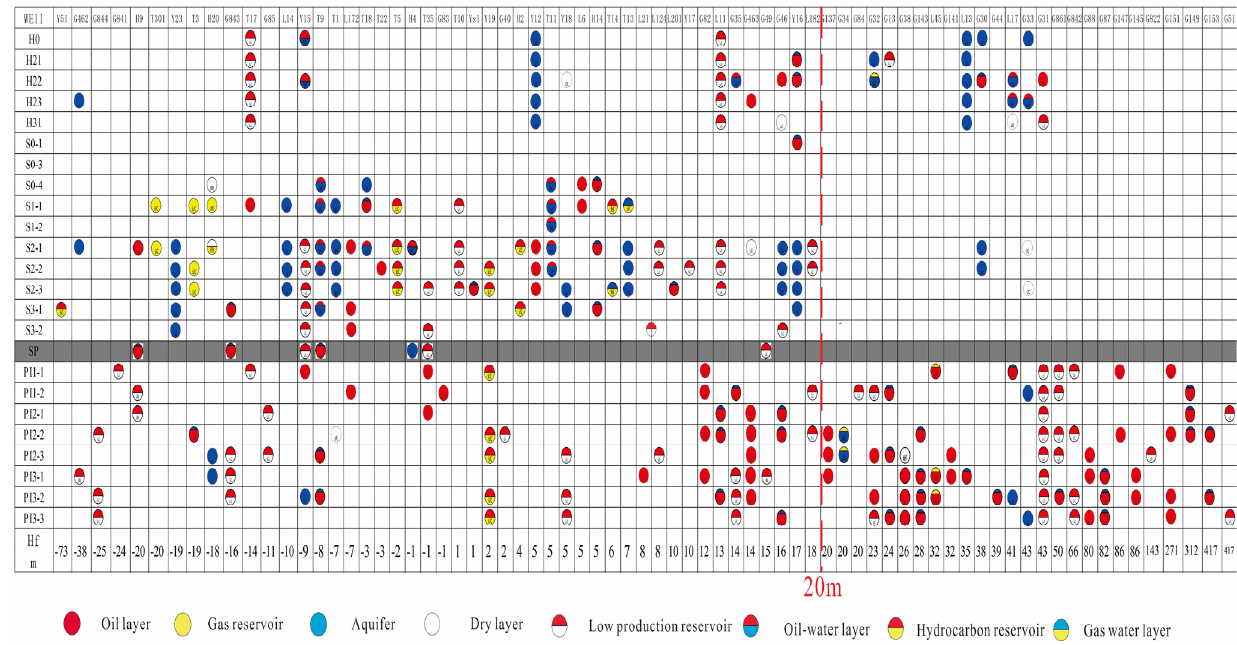
Figure 7. Determination of the maximum thickness of Sapu mudstone barrier required for hydro- carbon fluid migration from the Putaohua reservoir to the overlying Saertu reservoir in the Bayan Chagan Area.